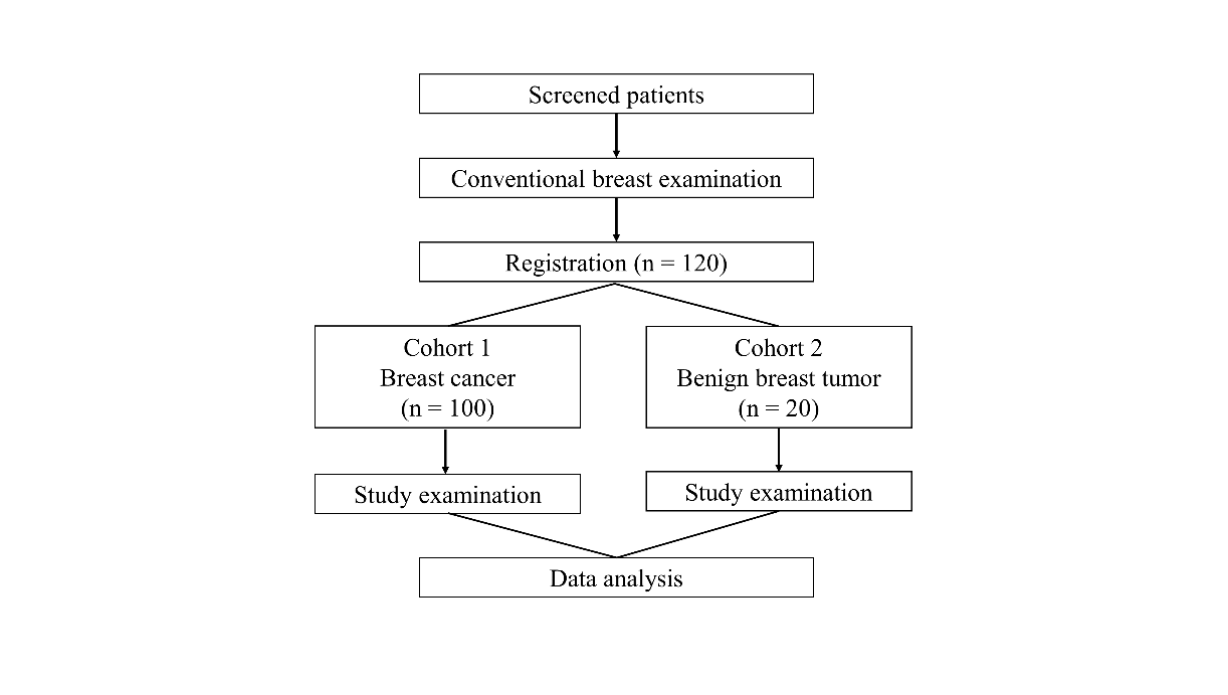
Figure 1. Study flowchart.